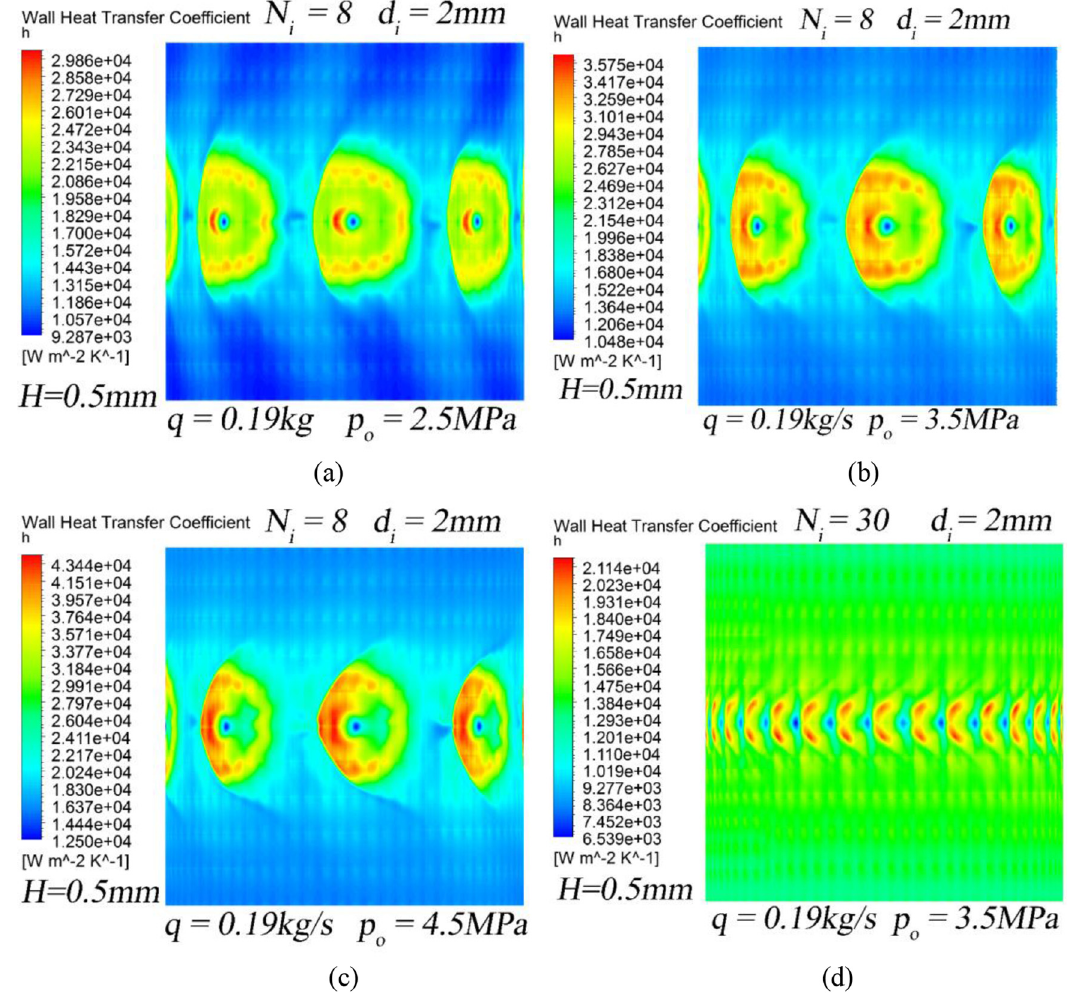
Fig. 6. The heat transfer coef fi cient contour maps with various outlet pressure. (a) N i =8, p o =2.5 MPa . (b) N i =30, p o =3.5 MPa .